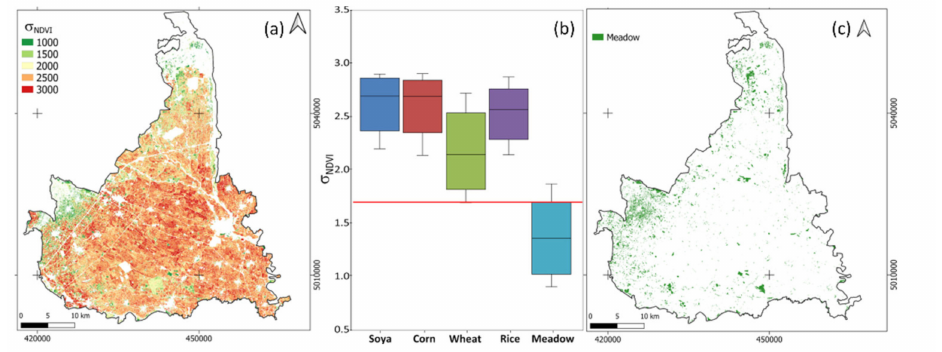
Figure 6. ( a ) σ NDVI map. ( b ) σ NDVI assessment for the crops analyzed, red line highlights the threshold identified to separate the meadows from other crops. ( c ) Fields classified as meadow (reference system is WGS84/UTM 32N, EPSG: